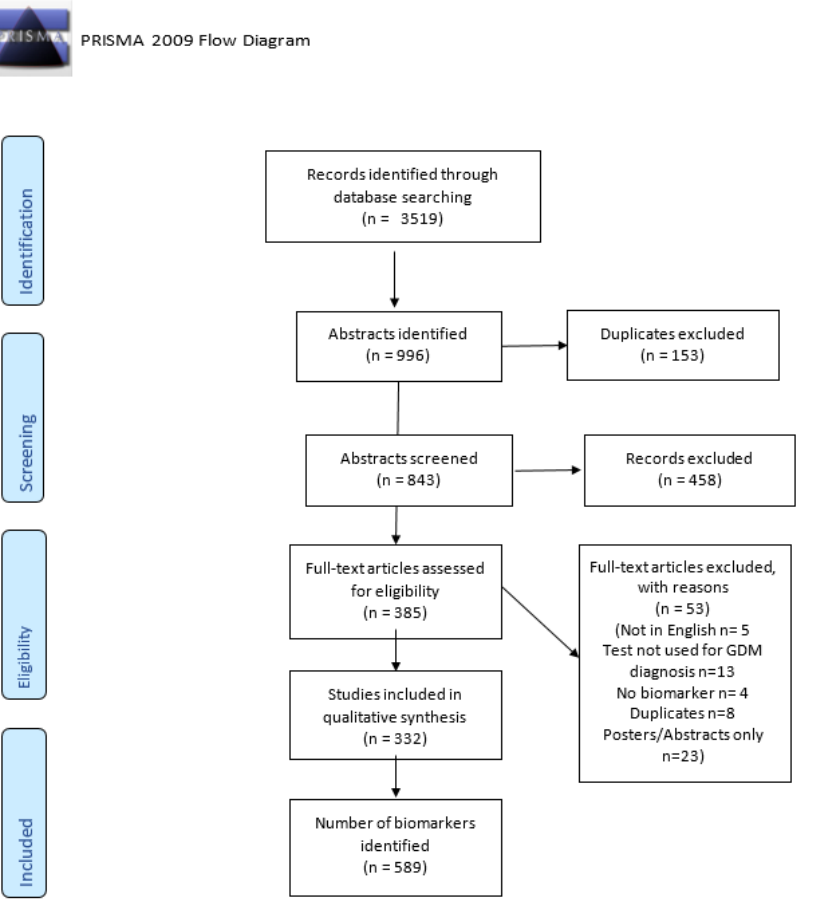
Figure 1. Prisma diagram.